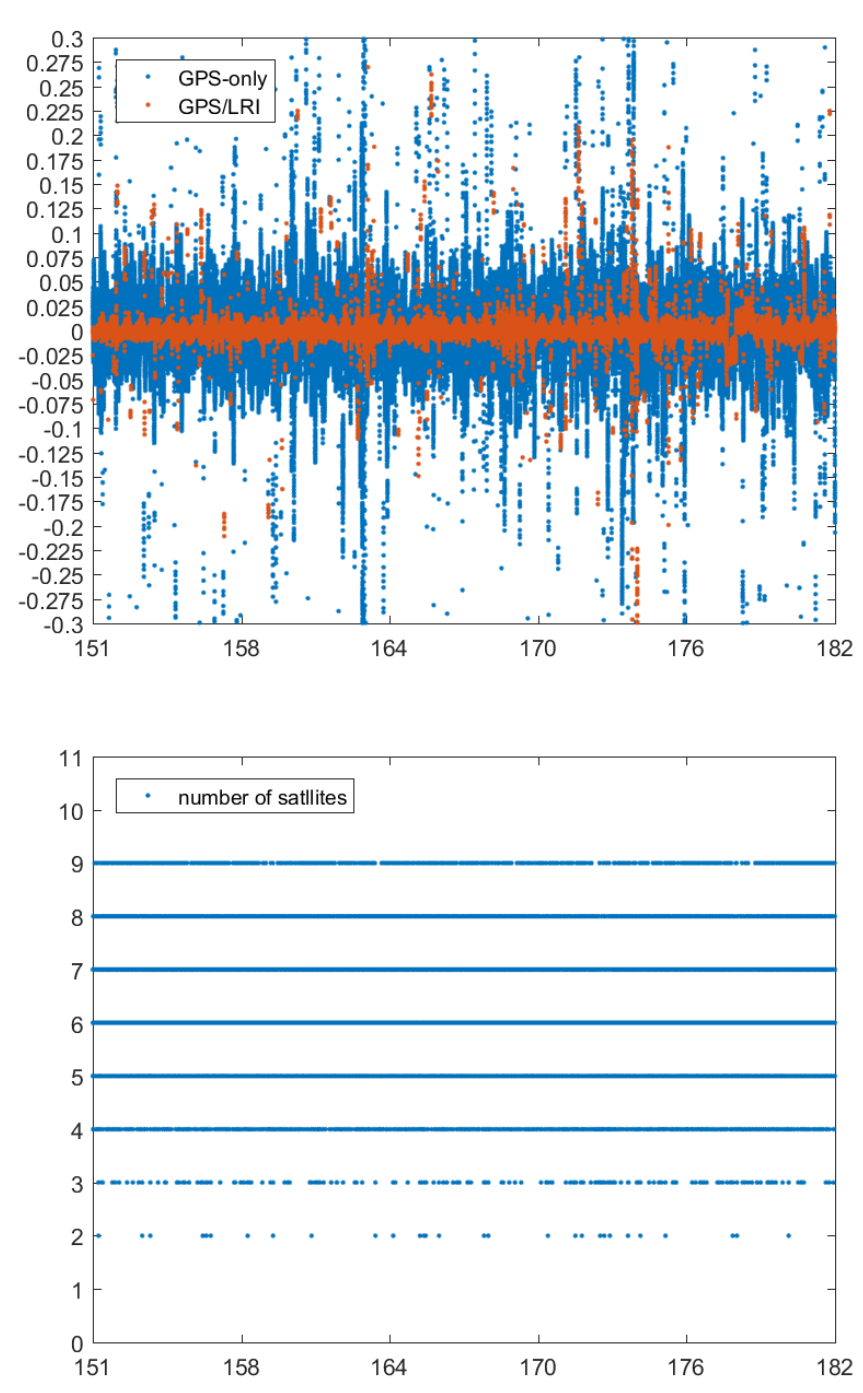
Figure 16. Day 151–182 KBR residuals (unit: m) for the GPS/LRI and GPS-only relative orbit and number of satellites.